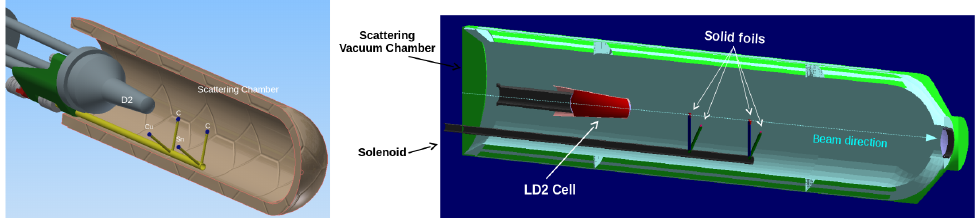
Figure 4. Left : the flag design with the 5 cm apart foils mounted on the same shaft (bottom yellow rod) with a 60 degrees opening between their holding needles (yellow upward sticks) that rotate together with a stepper motor. Each set of two foils will be inserted in the beamline simultaneously with an empty liquid deuterium (LD2) target cell. Right : a sliced GEMC (GEant-4 Monte-Carlo [53]) view of the Hall-B flag assembly along with the LD2 cell. The beam is anticipated to travel from left to right.